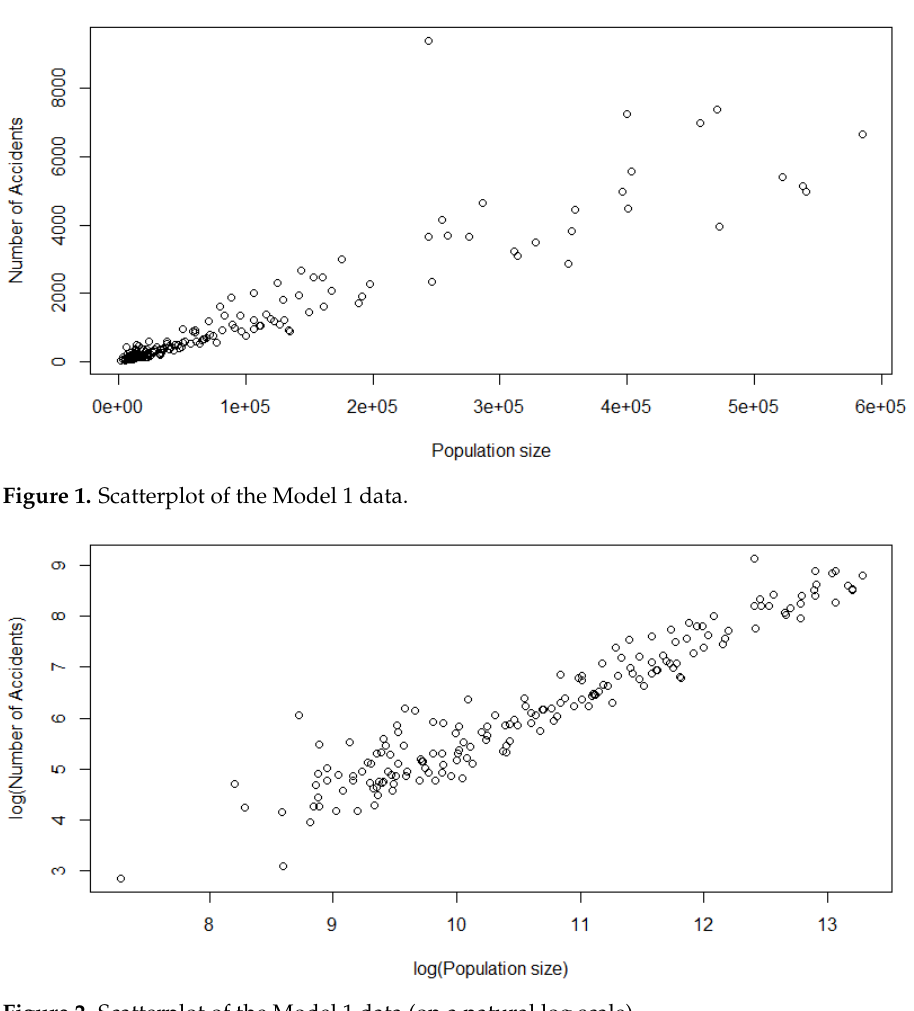
Figure 2. Scatterplot of the Model 1 data (on a natural log